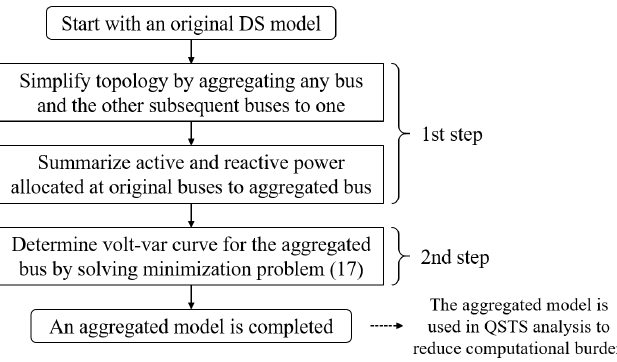
Figure 2. Flow of proposed bus aggregation